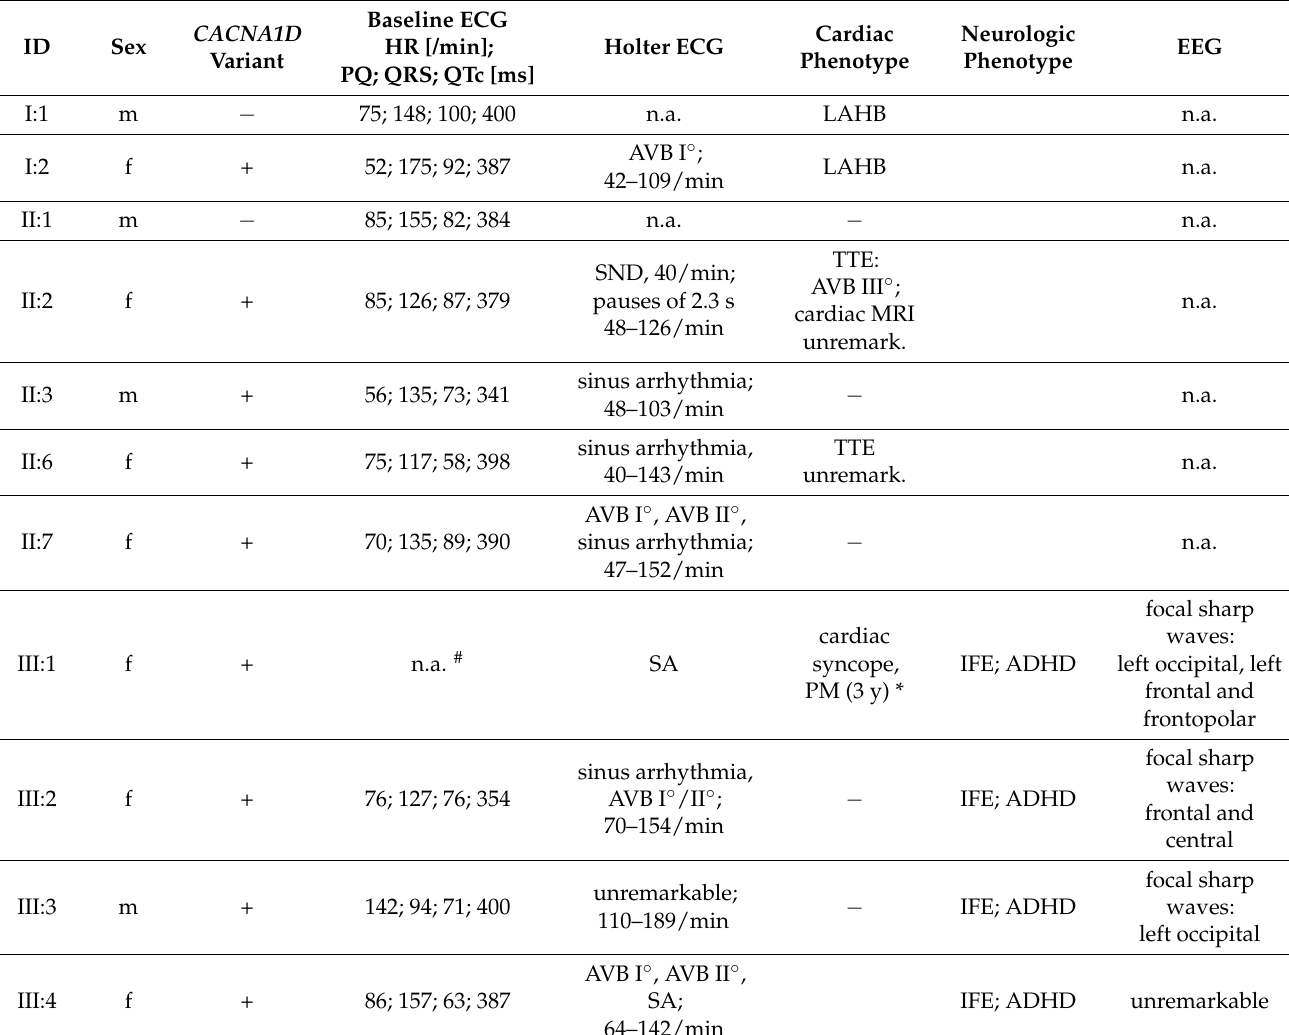
Table 1. Neurological and cardiac phenotypes in a family with a heterozygous CACNA1D variant, p.Arg930His